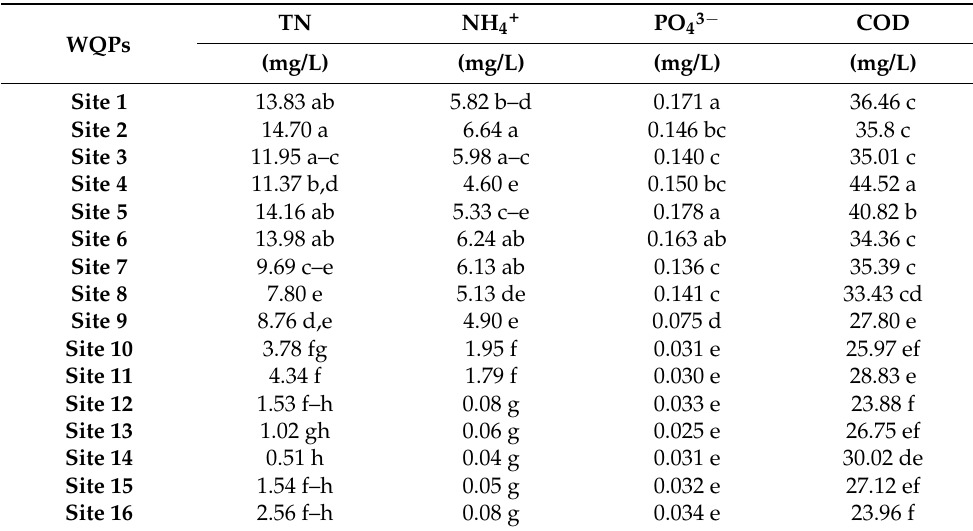
Table 3. Statistical analysis of four WQPs in Lake Qaroun over two years (2018–2019).